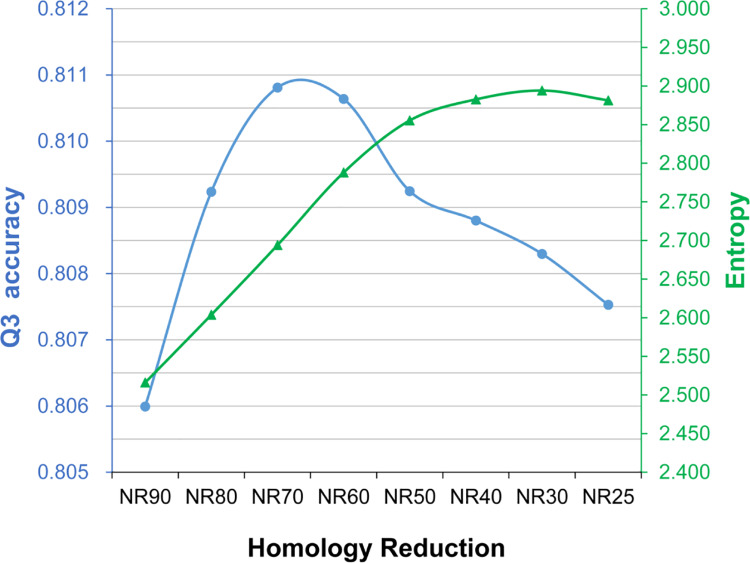
The average information entropy and Q3 accuracy of the assessed secondary structure prediction methods as the sequence homology of the target dataset reduces.The horizontal axis is the extent of target dataset homology reduction. The right vertical axis is the Shannon information entropy (green), and the left is the Q3 accuracy (blue). These two curves showed similar trends. The Pearson’s correlation coefficient was 0.417, a positive relationship.